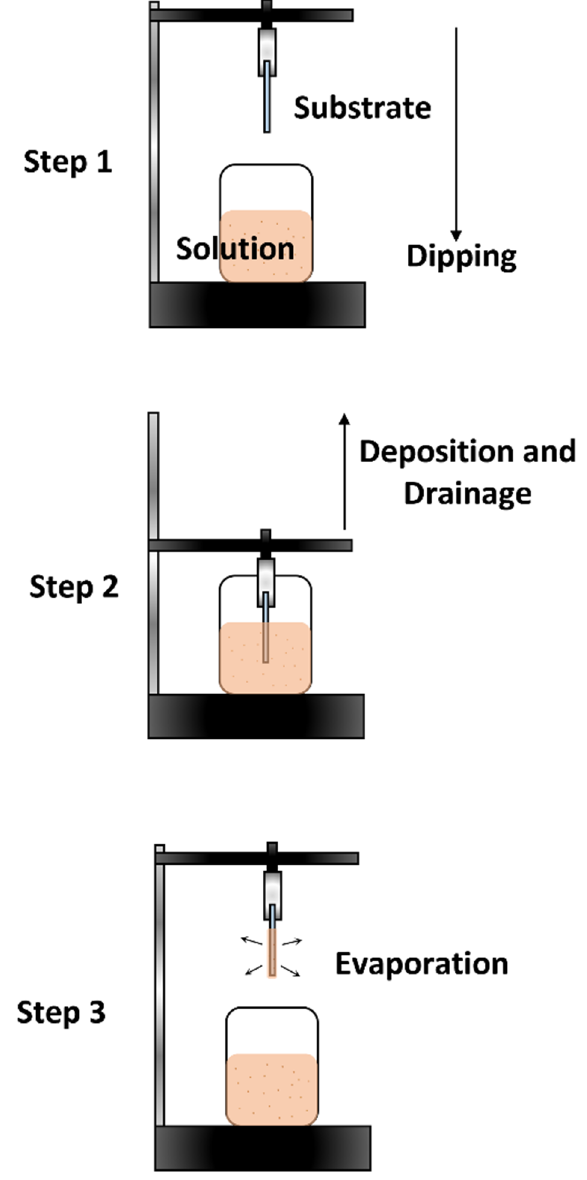
Figure 19. Dip coating method.